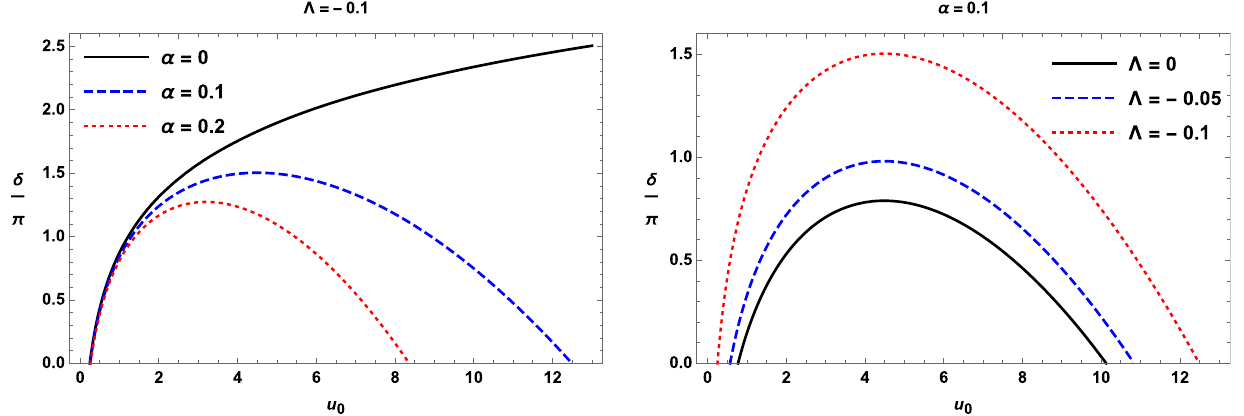
Fig. 6 The dependence of the bending angle of photon on the inverse of the distance of closest approach u